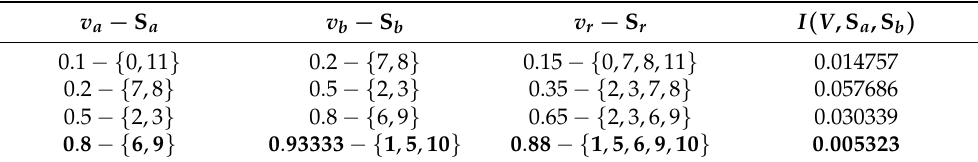
Table 2. Candidate structures for the second iteration. The best reduction is presented with bold typeface.